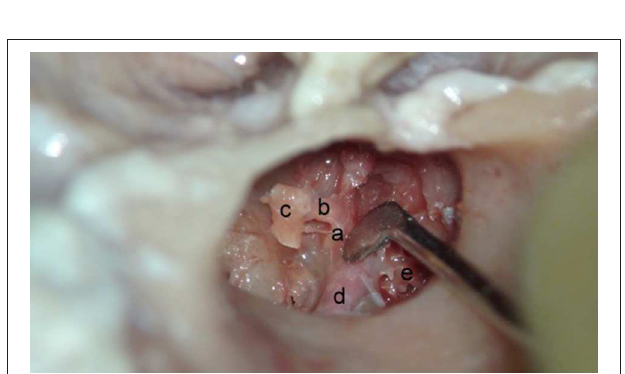
FIGURE 4 | Typical post-decompression, 27 year old man. Pre-operative photograph is 30 days after longitudinal fracture. Post-operative photograph